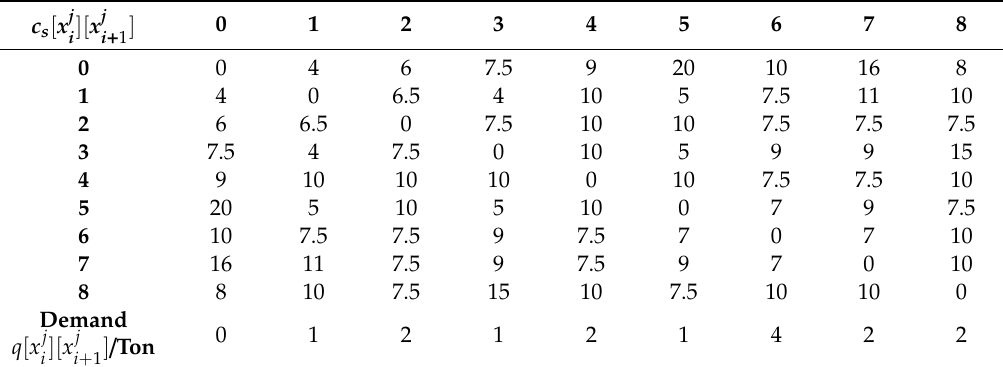
Table 1. Table of customer distance and demand.